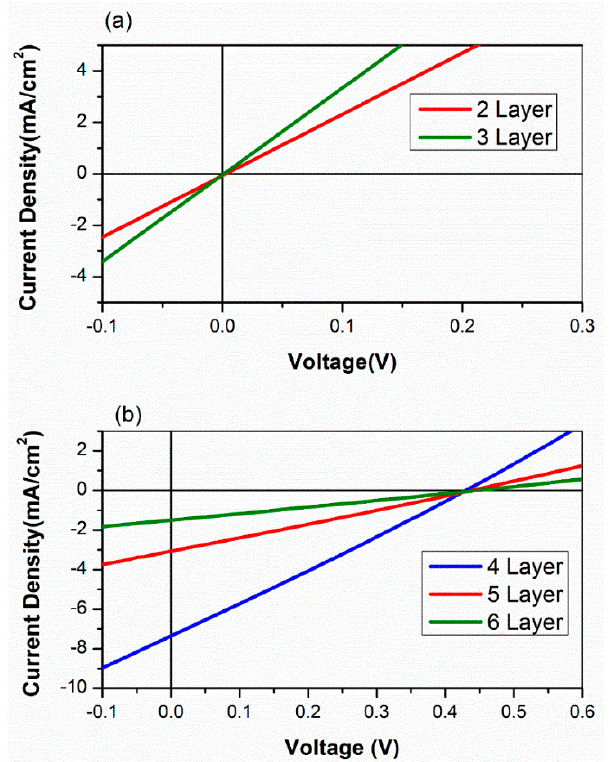
Figure 5. The J–V characteristics of PbS QD solar cells with different numbers of photoactive layers prepared using a drop cast method: ( a ) two or three layers; ( b ) four, five, or six layers. Nanomaterials 2019 , 9 , x FOR PEER REVIEW Table 1. Device parameters obtained from spin coating and drop cast methods.